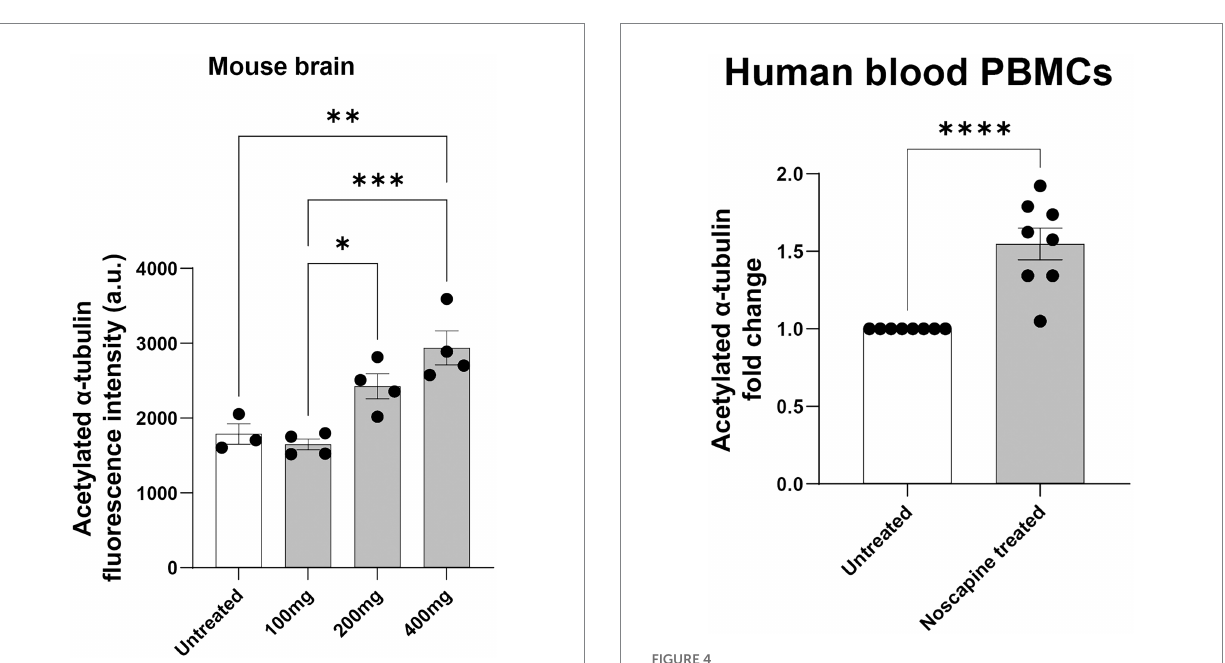
FIGURE 3 Acetylated α -tubulin levels in noscapine treated mouse. Acetylated α -tubulin was measured in the brain of the mouse dosed with noscapine. Mouse was orally administered with increasing concentrations of noscapine: 100, 200, and 400 mg/kg. One way ANOVA confirmed a significant noscapine treatment effect on acetylated α -tubulin in the mouse brain ( p < 0.01). Tukey’s post-hoc multiple comparisons showed group differences ( * p < 0.05, ** p < 0.01, *** p < 0.001). N = 3 or 4 mouse per group. a.u. = arbitrary unit. Mean ± SEM.